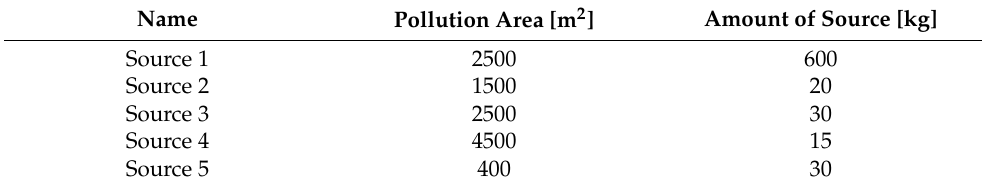
Table 3. Assumed sources of contamination at the site.